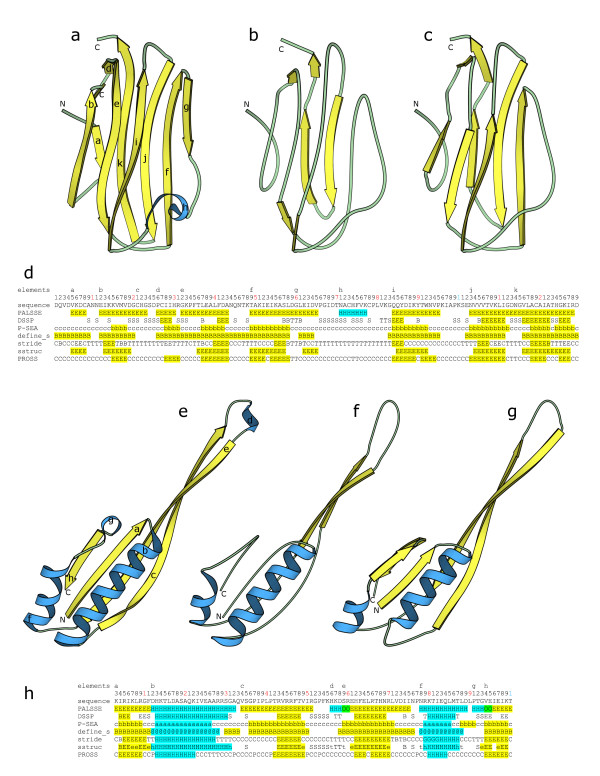
Two examples of secondary structure assignment by different programs. We chose an averaged NMR structure "1ahk" and a low-resolution X-ray structure (3.0Å) "1fjg" to show as examples since over-prediction by our method is maximum for such structures. Only chain "J" of "1fjg" is shown. Figs. a, b, c show cartoon diagrams of "1ahk", prepared using MOLSCRIPT [46], for β-strand and α-helix definitions by our program, DSSP [8] and P-SEA [17] respectively. β-Strands are shown in yellow and helices in cyan. The N- and C- termini are marked for each structural diagram. The elements produced by our program are labeled. Fig. d shows the secondary structure assignment for "1ahk" by PALSSE (our program), DSSP, P-SEA, DEFINE_S, STRIDE, SSTRUC and PROSS. Our interpretation of β-strands and helices as defined by the different programs are colored in yellow and cyan respectively. The starting positions of each element labeled in fig. a are shown on the first line. The sequence is numbered on the second line with black letters denoting units, red denoting tenths and blue denoting the hundredths places. The protein sequence is shown in the third line. Figs. e, f, g shows cartoon diagrams of chain "J" of "1fjg", prepared using MOLSCRIPT [46], highlighting β-strand and helix definitions by our program, DSSP, and P-SEA respectively. β-Strands are in yellow and helices are shown in cyan. Elements are labeled in fig. e. Fig. h shows the secondary structure alignment for "J" chain of "1fjg". Definitions produced by the same programs as that used for fig. d are shown. Yellow color is used for our interpretation of β-strands and cyan denotes our interpretation of helices. Green has been used to denote overlaps between helix and β-strand elements defined by our program. The first, second, and third lines show start of each element in fig. e, residue number and sequence respectively, similar to fig d. DSSP, P-SEA, DEFINE_S, SSTRUC, STRIDE and PROSS assignments were generated by obtaining the programs, and then compiling and running them with default parameters on the example PDB files.